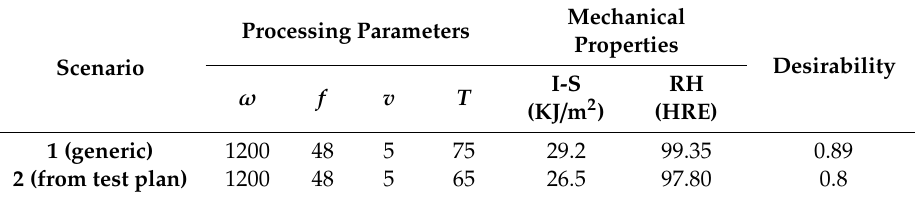
Table 7. Optimum conditions to maximize impact strength and Rockwell